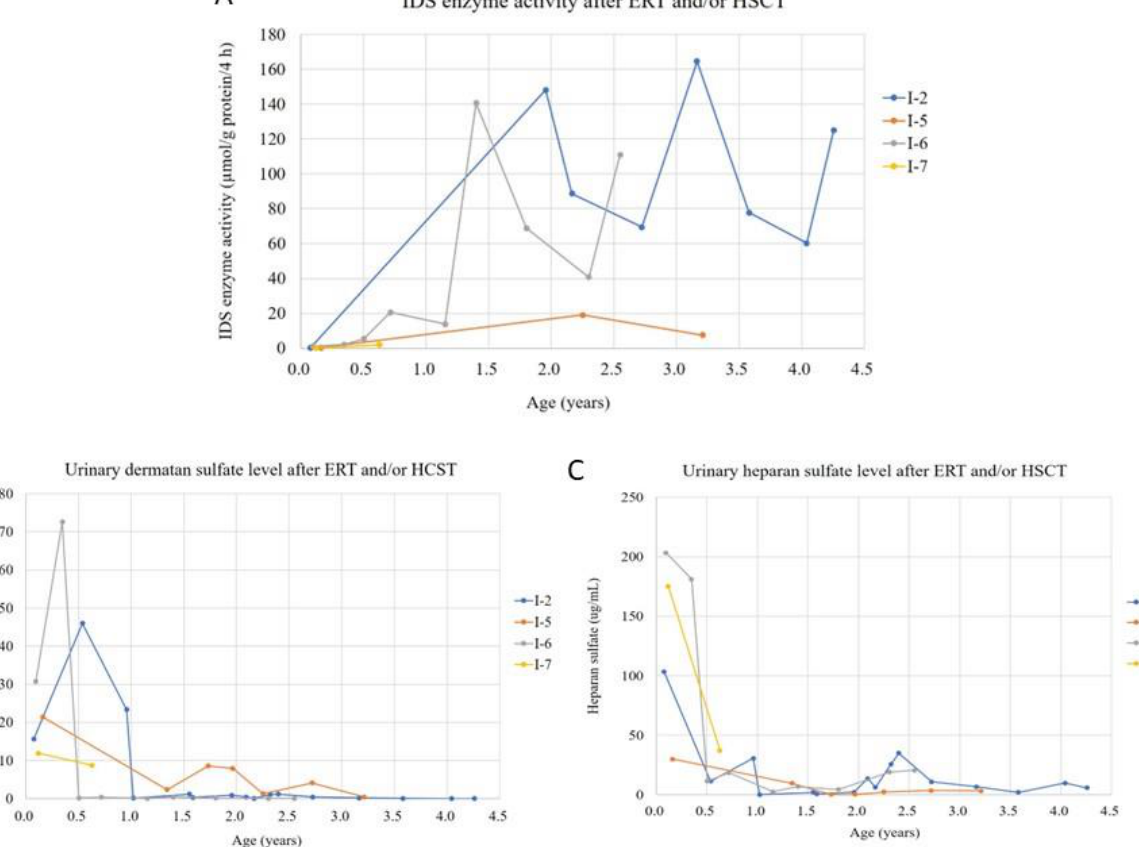
Figure 4. The IDS enzyme activity ( A ), urinary dermatan sulfate ( B ), and urinary heparan sulfate ( C ) quantities for four MPS II patients diagnosed through the newborn screening program who received early ERT and/or HSCT. After ERT and/or HSCT, all results significantly improved compared with the baseline data. Intravenous ERT was started in four patients (No. I-2, I-5, I-6, I-7) at 1, 0.5, 0.4, and 0.5 years of age, respectively. Patients No. I-2, I-6, and I-7 also received HSCT at 1.5, 0.9, and 0.6 years of age, respectively. IDS, iduronate-2-sulfatase. ERT, enzyme replacement therapy; HSCT, hematopoietic stem cell transplantation.